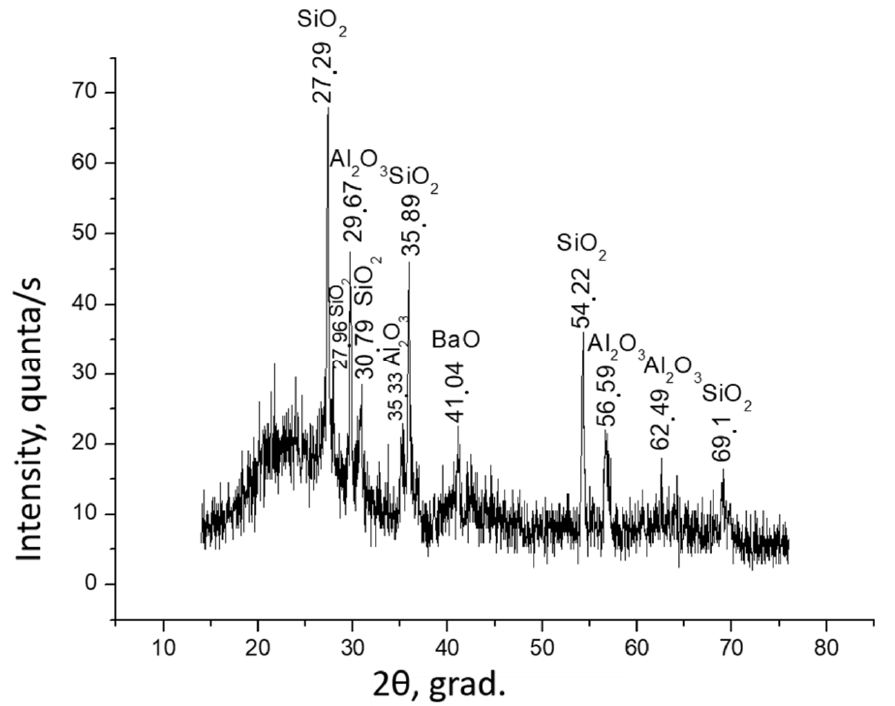
Figure 11. X-ray diffraction pattern of a thin film of vanadium dioxide № 2 indicating the angles 2 θ in degrees and the substance above each diffraction peak.